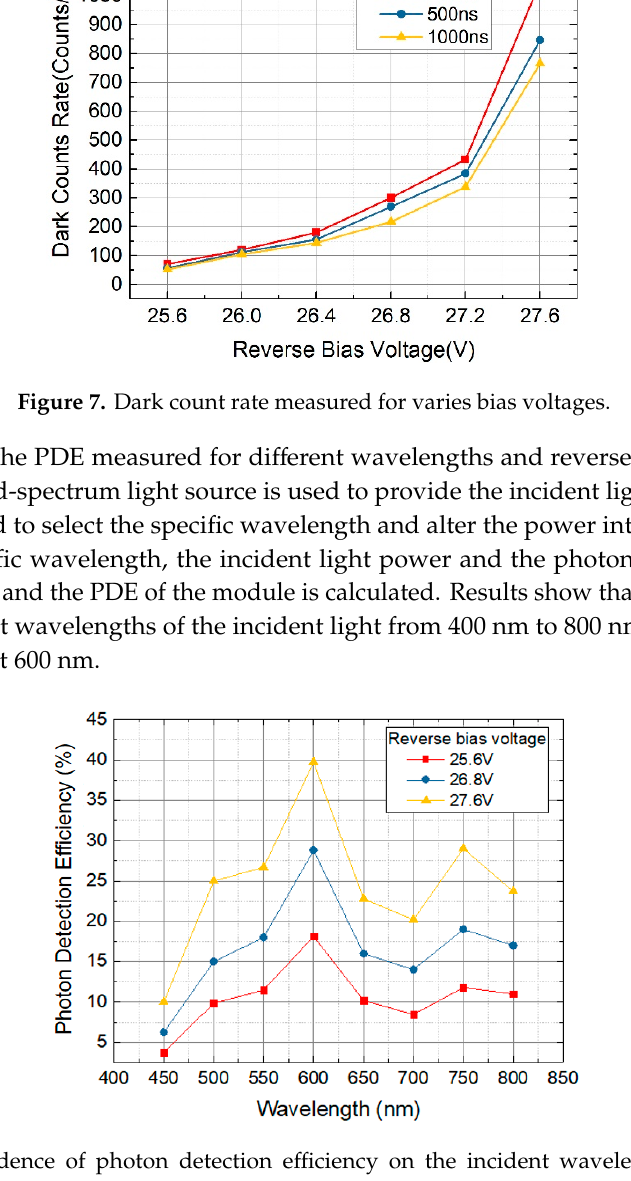
Figure 8. Dependence of photon detection efficiency on the incident wavelength for different bias voltages.